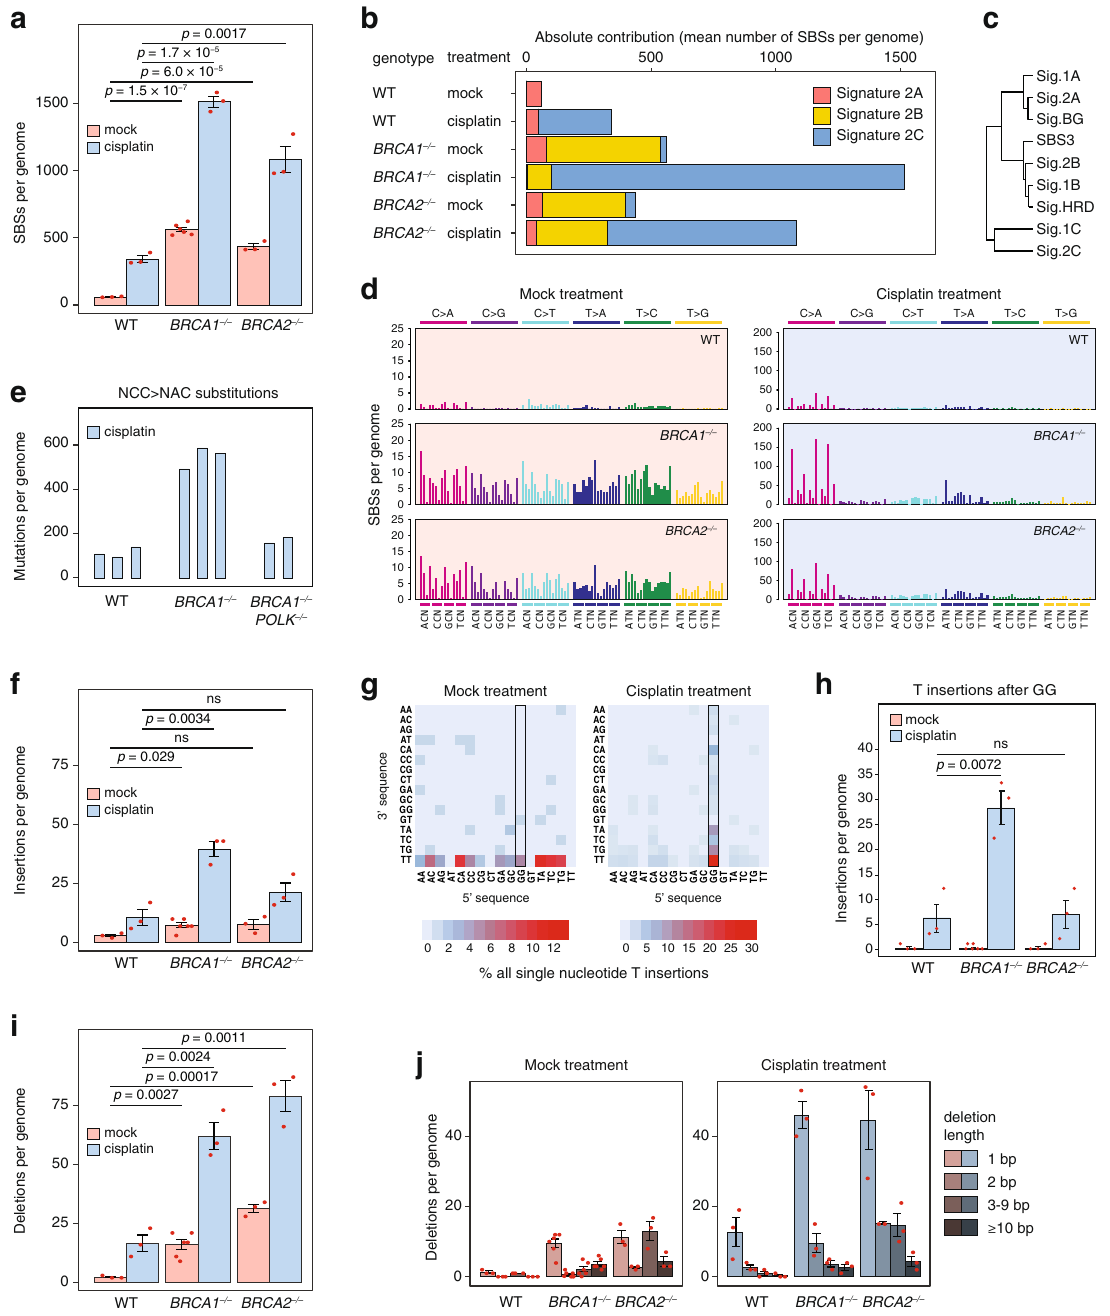
Fig. 2 Increased TLS-mediated mutagenesis at replication-stalling lesions in BRCA1/2 de fi cient cells. a The mean number of SBS (single base substitution) mutations detected in DT40 cell clones of the indicated genotypes following mock treatment or four 1-h treatments at weekly intervals with 10 μ M cisplatin. b Deconstruction of the averaged triplet SBS spectra of the indicated genotypes and treatments into three mutational signatures using non- negative matrix factorisation. c Hierarchical clustering of newly de fi ned and published SBS signatures, see text for details. d Mean triplet spectra of the SBS mutations shown in panel ( a ), presented as in Fig. 1e. Note the different y axis scale used for mock and cisplatin treatments. e The total number of NCC > NAC substitutions in individual sequenced cisplatin-treated samples of the indicated genotypes. f The mean number of insertion mutations in the samples presented in ( a ). g The sequence context of single T insertions, presented as a heat map of summed events in all mock treated (left panel) or cisplatin-treated (right panel) samples shown in ( f ). h The mean genomic number of T insertions after GG dinucleotides (boxed in panel g ) in samples of the indicated genotype and treatment. i The mean number of deletion mutations in the samples presented in ( a ). j The mean number of deletions presented in categories separated according to deletion size. Error bars indicate SEM on all panels, individual values are also shown with red symbols on ( a , f , h – j ). The signi fi cance of tested differences is shown (ns not signi fi cant, unpaired two-sided t -test, data presented in ( a , f , h – j ) were derived from genome sequencing of n = 3 biologically independent samples per genotype and treatment except n = 6 for mock treated BRCA1 – / – cells). Source data are provided as a Source Data fi